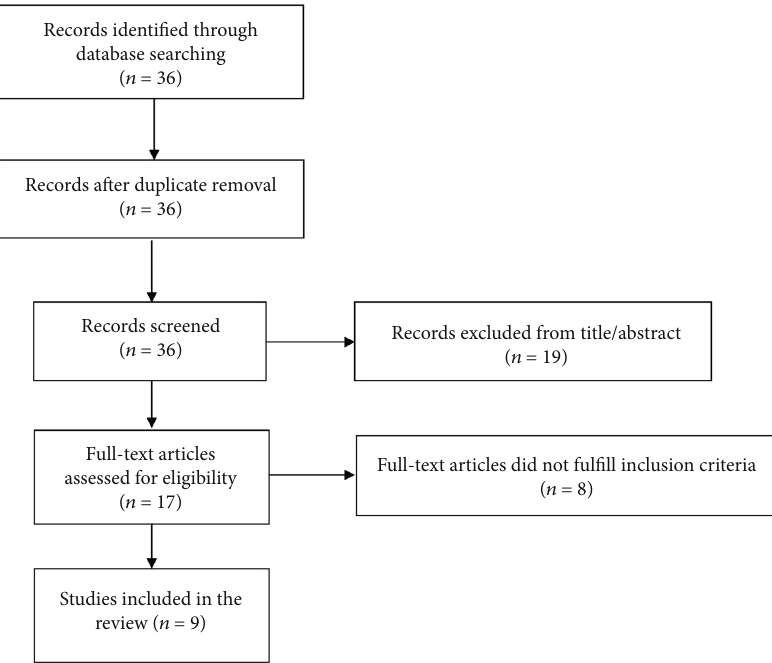
Figure 3: Flowchart diagram for inclusion and exclusion of papers. Table 1: Studies and patients